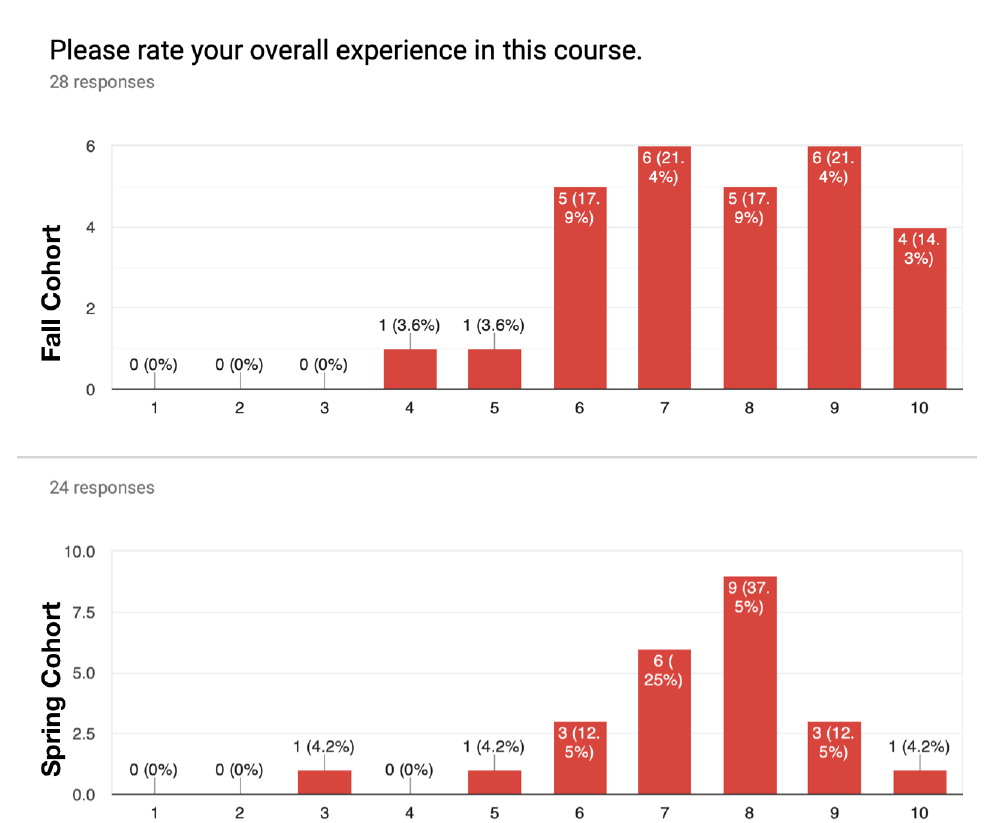
Figure 5. Overall experience of students. Fall cohort satisfaction displays a distinctive high-approval rate, and we attribute this due to the excitement with first time offering of this course, as well as the opportunity to showcase design projects to the faculty in the department. Spring cohort opinions exhibit regular bell curve peaked around 8/10, which is